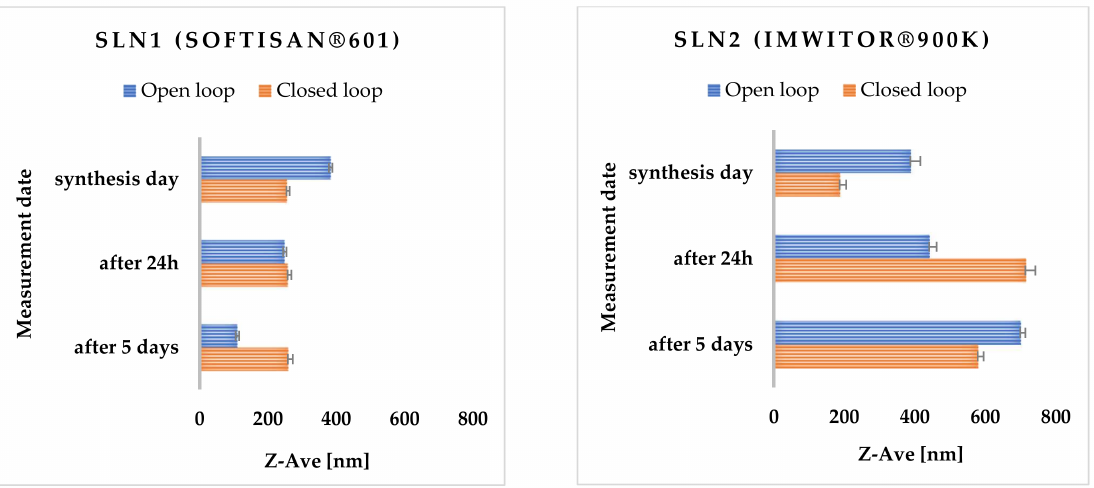
Figure 1. Comparison of the average particle size (Z-Ave) of the obtained SLNs synthesized using lipids Softisan ® 601 and Imwitor ® 900, and the surfactant Poloxamer 188, measured on the day of synthesis, and additionally 24 h and 5 days after the synthesis. The process of obtaining nanoparticles was carried out in an open-loop as well as a closed-loop system, under 300 bar pressure in three